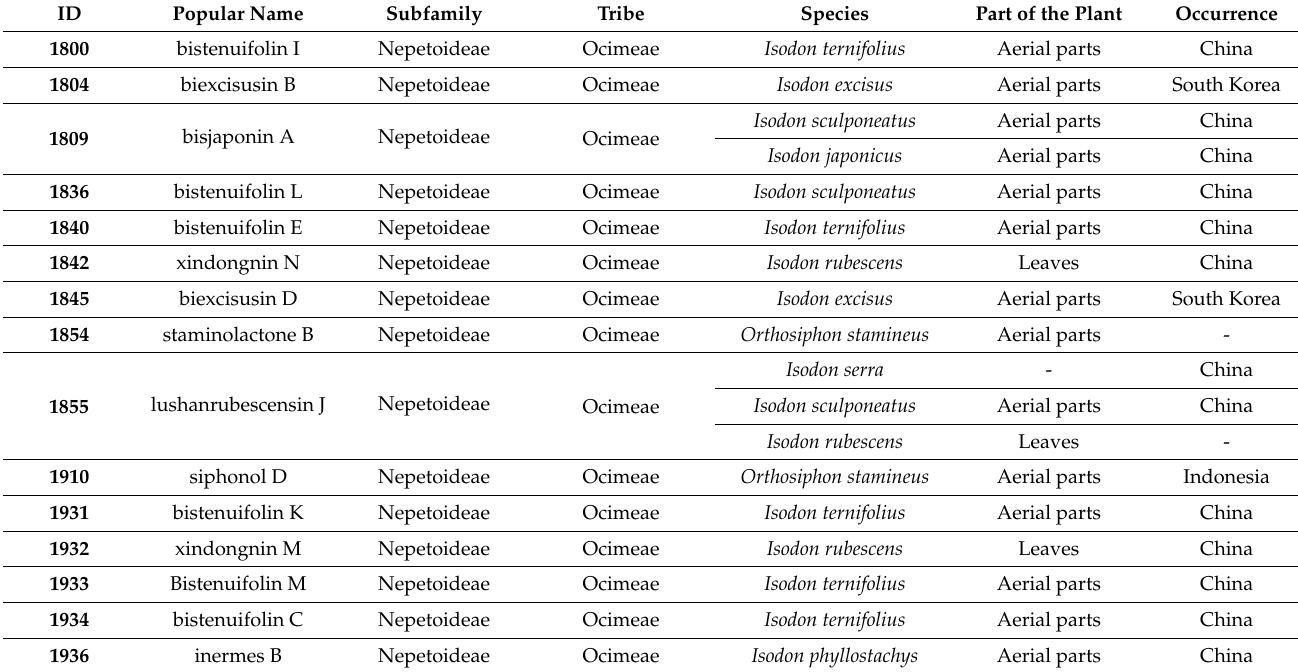
Table 6. Distribution of diterpenes considered active against A. gossypii, with information on the subfamily Nepetoideae (Lamiaceae) listed by tribe, genus, and species (presenting plant data, and occurrence), is available on the SistematX (https://sistematx.ufpb.br)